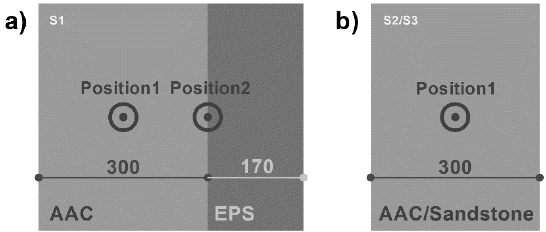
Figure 5. Sample structures, according to Table 2 (inside left). ( a ) An external test cell wall; and ( b ) simple AAC and sandstone walls. The placement position for the plotted data are: the calculated temperatures in Figures 8 and 10 in specimen S2 / S3, in Figures 12 and 13 in S1 and the measured temperatures in Figures 15–17 in specimen S1.